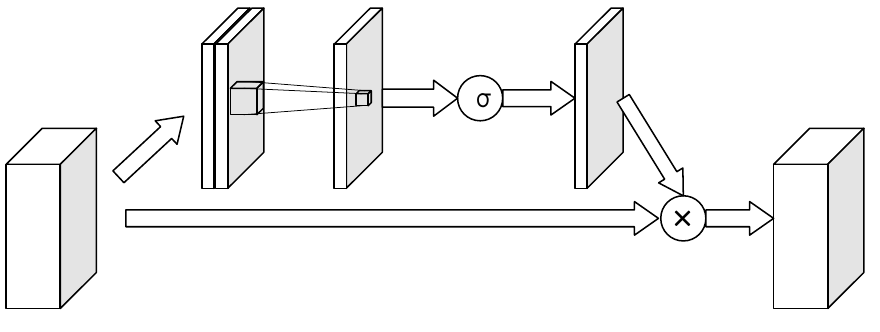
Figure 2. Spatial Attention module. Figure 2. Spatial attention